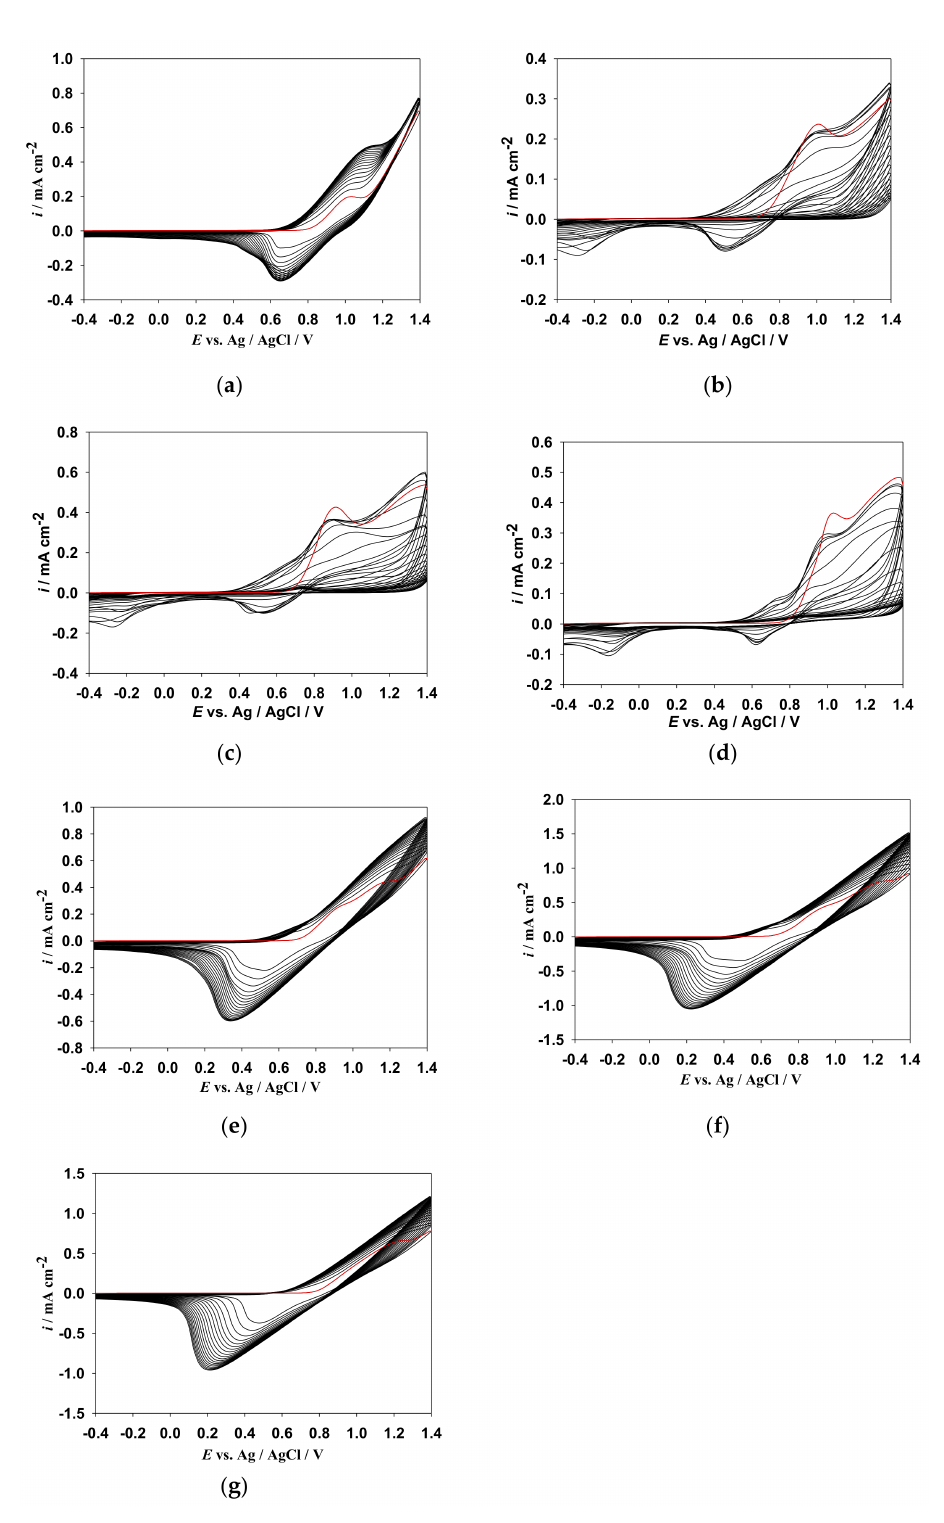
Figure 2. Cyclic voltammograms of ( a ) 2 mM TTPA; ( b ) 2 mM MPS; ( c ) 2 mM MPO; ( d ) 2 mM ANIL; ( e ) 1 mM TTPA + 1 mM MPS; ( f ) 1 mM TTPA + 1 mM MPO and ( g ) 1 mM TTPA + 1 mM ANIL in 0.1 M LiClO 4 /ACN at a scan rate of 100 mV s − 1 . TTPA: tris(4-(thiophen-2-yl)phenyl)amine; MPS: